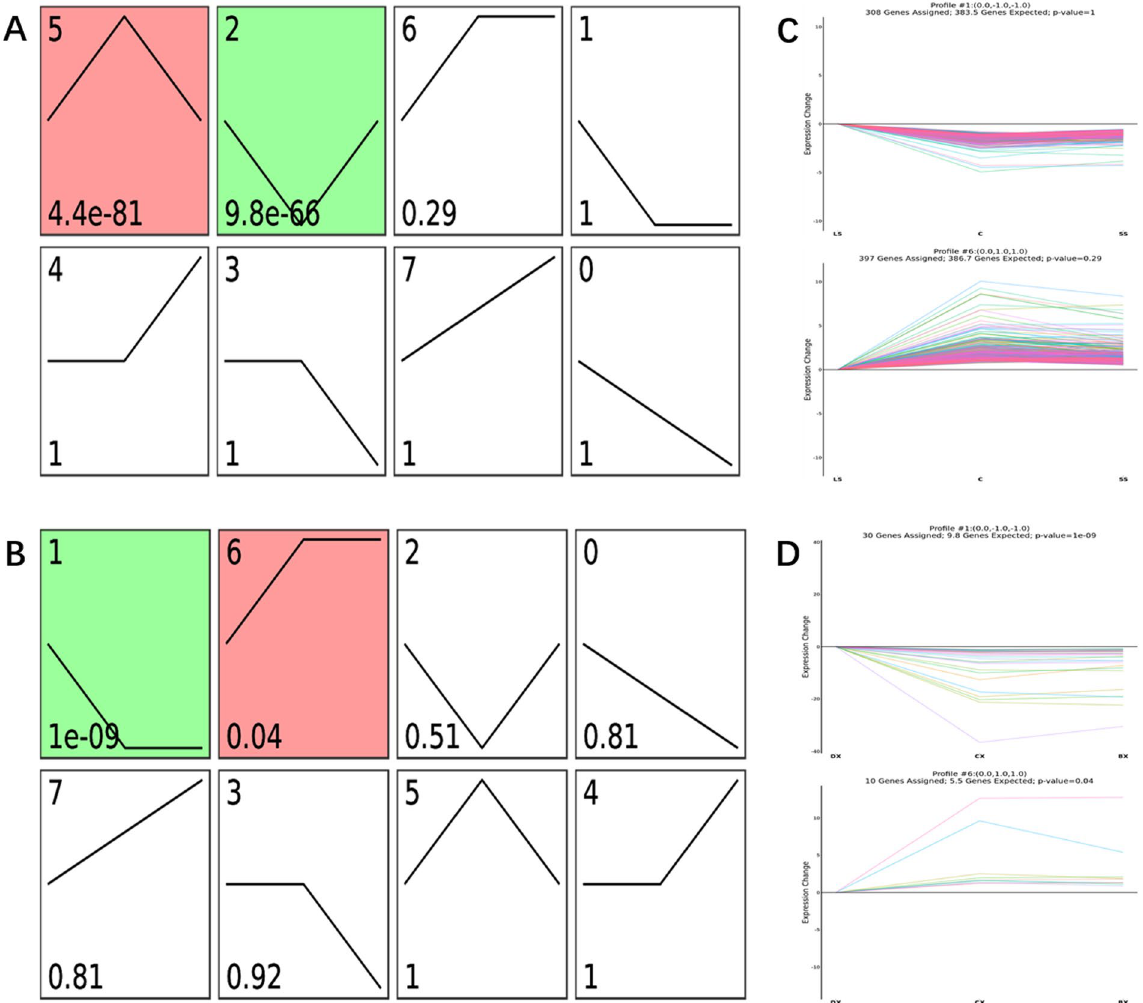
Figure 5. STC analysis of differentially expressed miRNA and mRNA in microarray. ( A,B ) Eight model profiles were utilized to illustrated the expression patterns of 4931 differentially expressed mRNA ( A ) and 119 expression expressed miRNA transcript ( B ), respectively. Each box represents a different model expression profile. The p value and corresponding model profile number were listed in upper and lower corner of each profile box, respectively. ( C,D ) 2 model expression profiles of mRNA transcripts ( C ) with statistically significant (p < 0.05) and relevant expression profiles miRNA ( D ) are shown, respectively. Model expression profile number, the number of genes assigned to its corresponding profile, the number of genes expected to its corresponding profile and p-value are shown on the top of each profile. The horizontal and vertical axes represent indicated time points and the time series of gene expression levels after Log normalized transformation, respectively. Fisher exact test for ( A and B